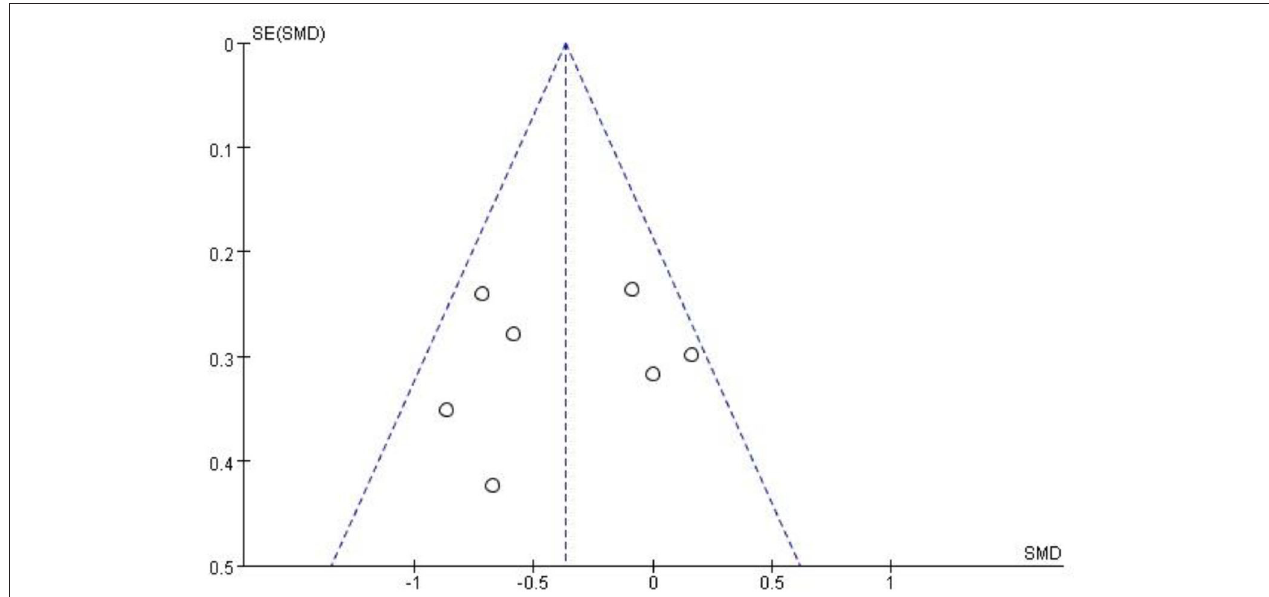
FIGURE 10 | Funnel